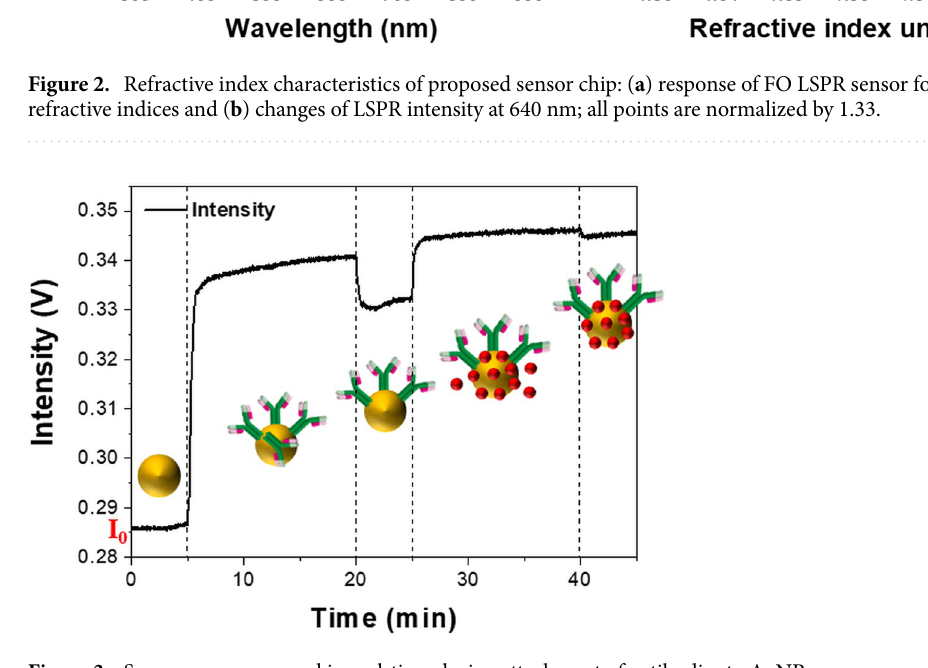
Figure 3. Sensorgram measured in real-time during attachment of antibodies to